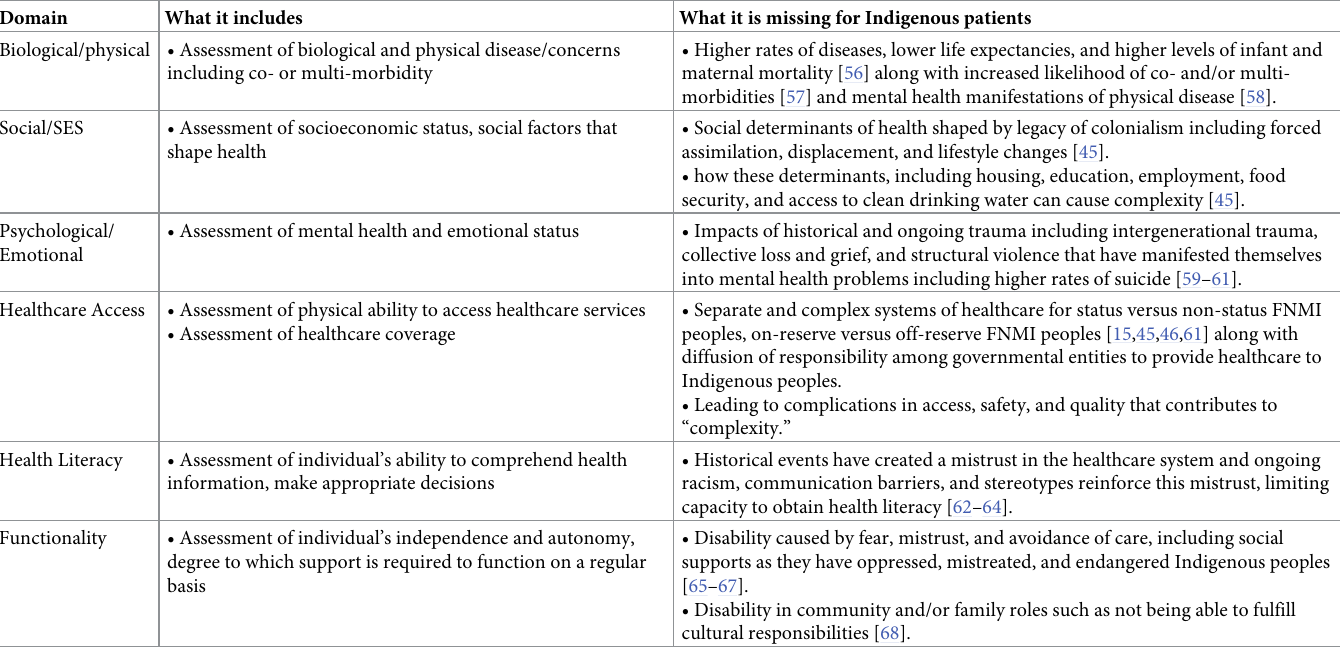
Table 4. Pre-existing domains contextualized for Indigenous